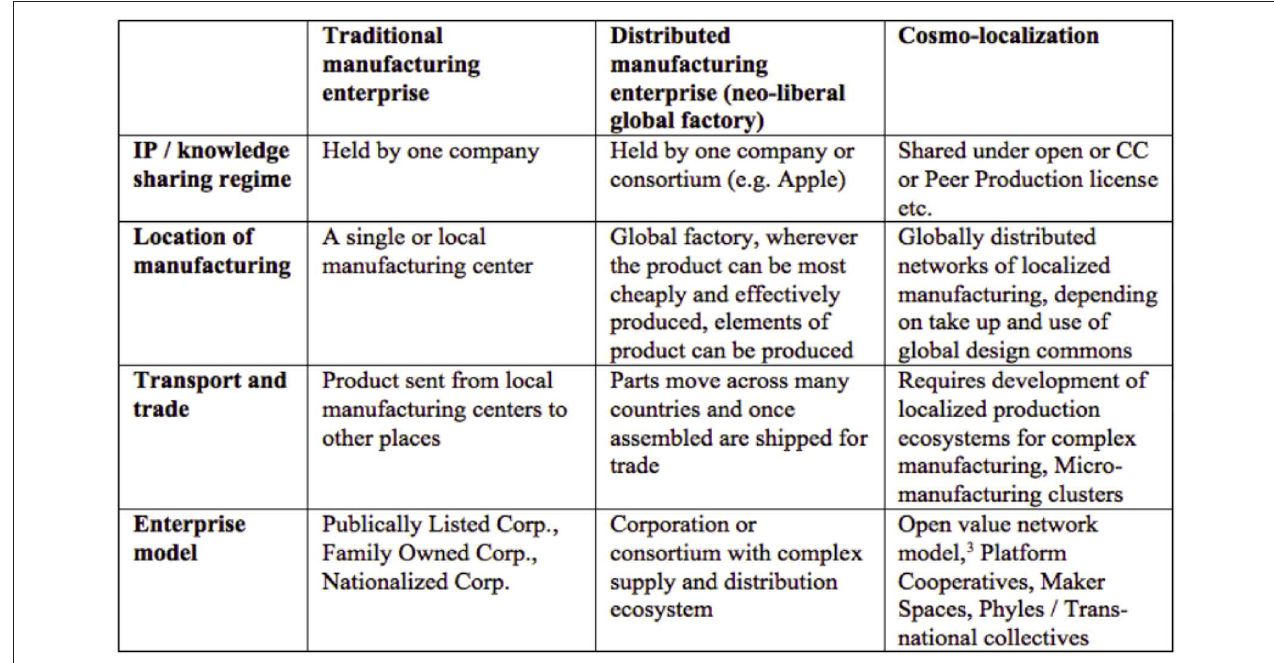
FIGURE 5 | Cosmo-local production [used with permission. Graphic by Ramos